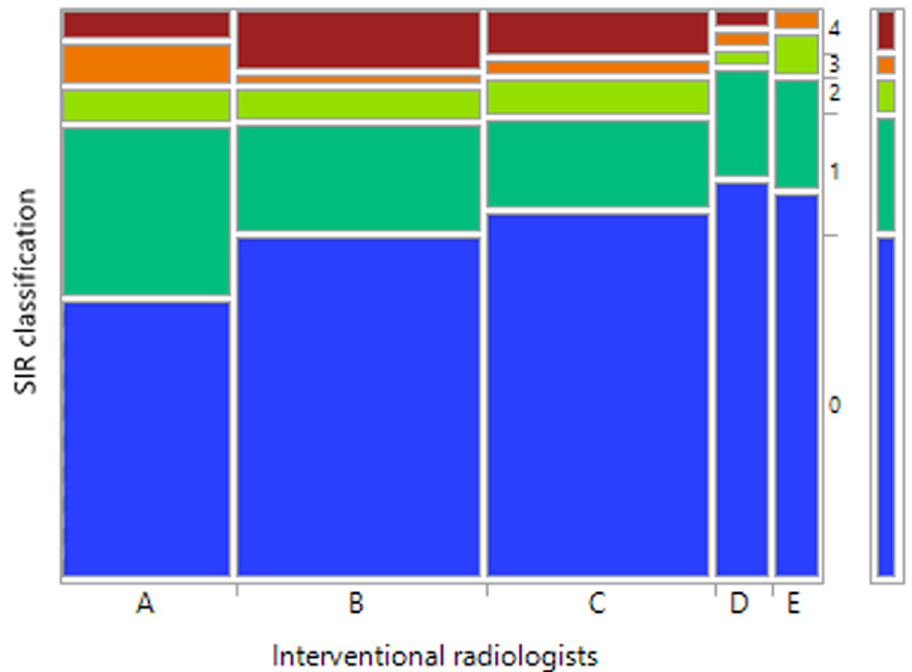
Fig 5. SIR classification in relation to interventional radiologists performing the biopsies. Mosaic plot in the study group (n = 311).